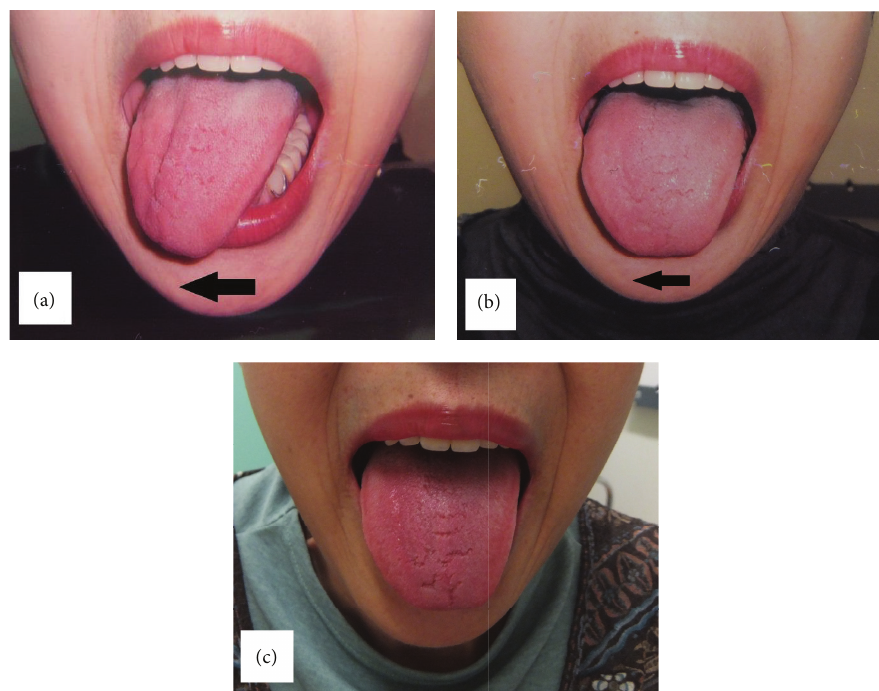
Figure1:(a)Physicalexaminationofthetongueonpostoperativeday1.Thetonguewasdeviatedtotherightsideonprotrusiondemonstrating the right hypoglossal nerve palsy. (b) Physical examination of the tongue three months later. The deviation of the tongue slightly improved. (c) Physical examination of the tongue five months later. The deviation of the tongue disappeared showing a complete recovery of hypoglossal nerve